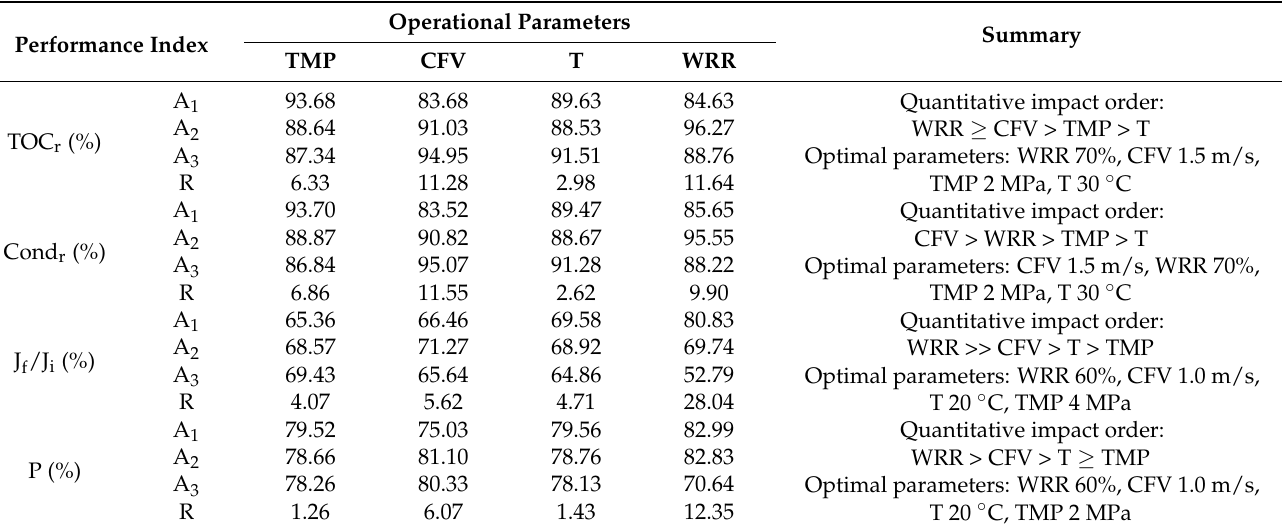
Table 6. Range analysis of the orthogonal tests for Vontron HOR RO